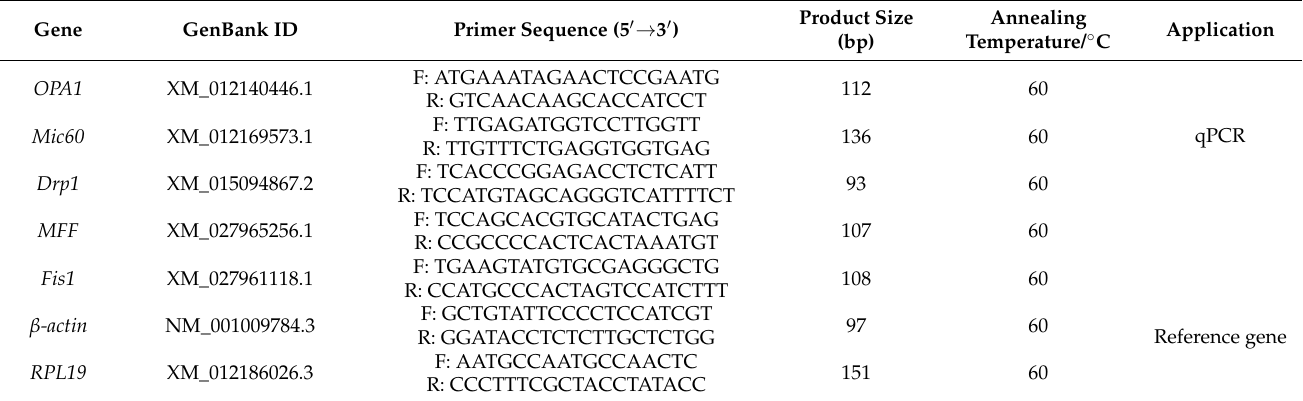
Table 1. The primer information on mitochondria dynamic-related